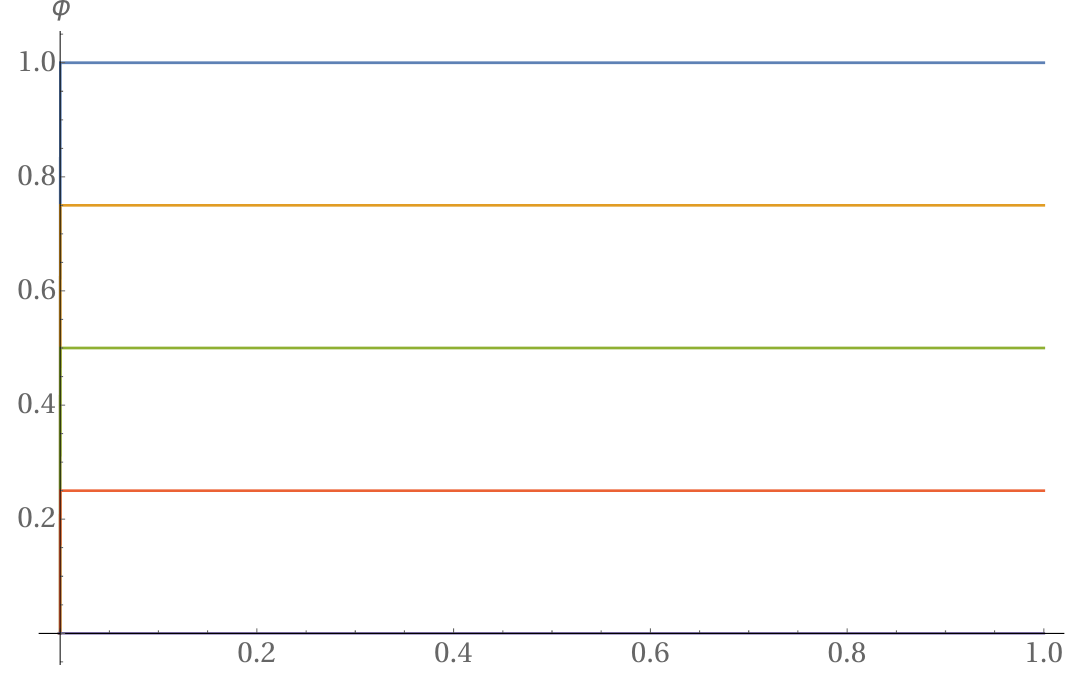
Figure 2 . Cartoon of the qualitative attractor behavior we expect in in(cid:12)nite dimensions. The (cid:12)elds remain constant until one reaches the horizon where they suddenly jump to their attractor